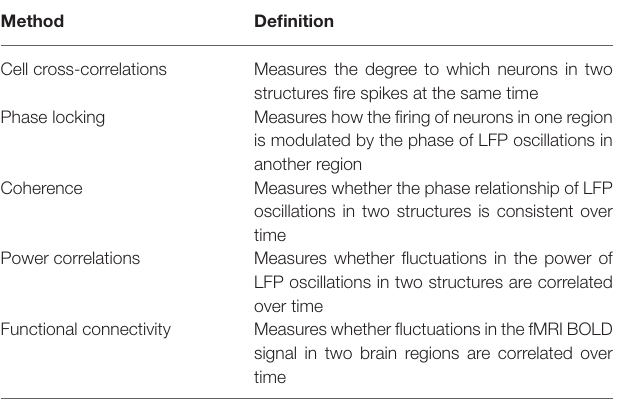
TABLE 1 | Overview of methods used to measure interactions between brain